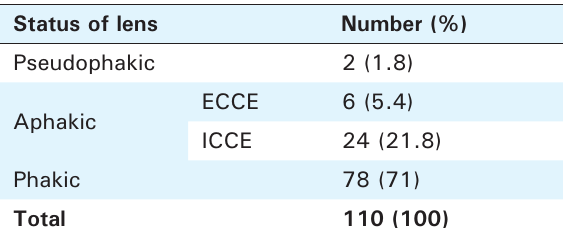
Table 2. Distribution of status of lens